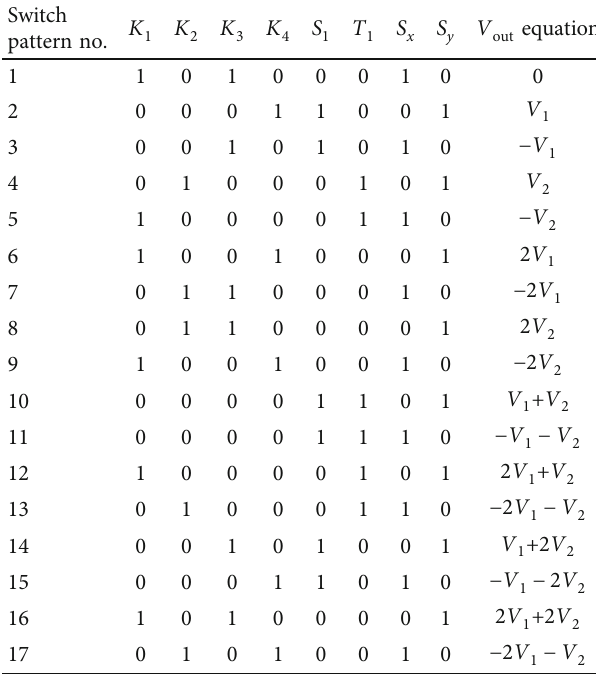
Figure 19: Current fl ow for the 17 th switching pattern. Table 1: Switching states of a multilevel